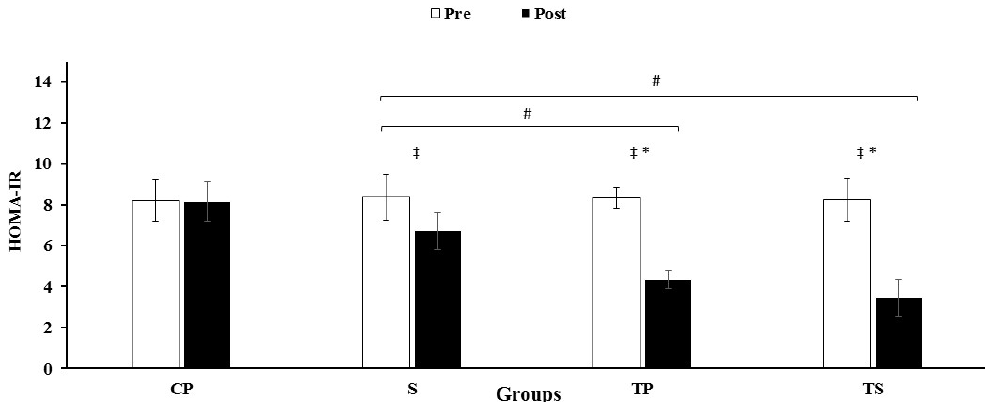
Figure 5. Pre and post training values (mean ± SD) for HOMA-IR in CP, Control–Placebo; S: Supplement; TP, Training– Placebo; TS, Training–Supplement groups. * indicates significant differences with control group ( p < 0.05). * indicates sig- nificant differences compared to the control group ( p < 0.05). # indicated significant differences compared to S group ( p < 0.05). ‡ indicated signi fi cant di ff erence from baseline ( p < 0.05).